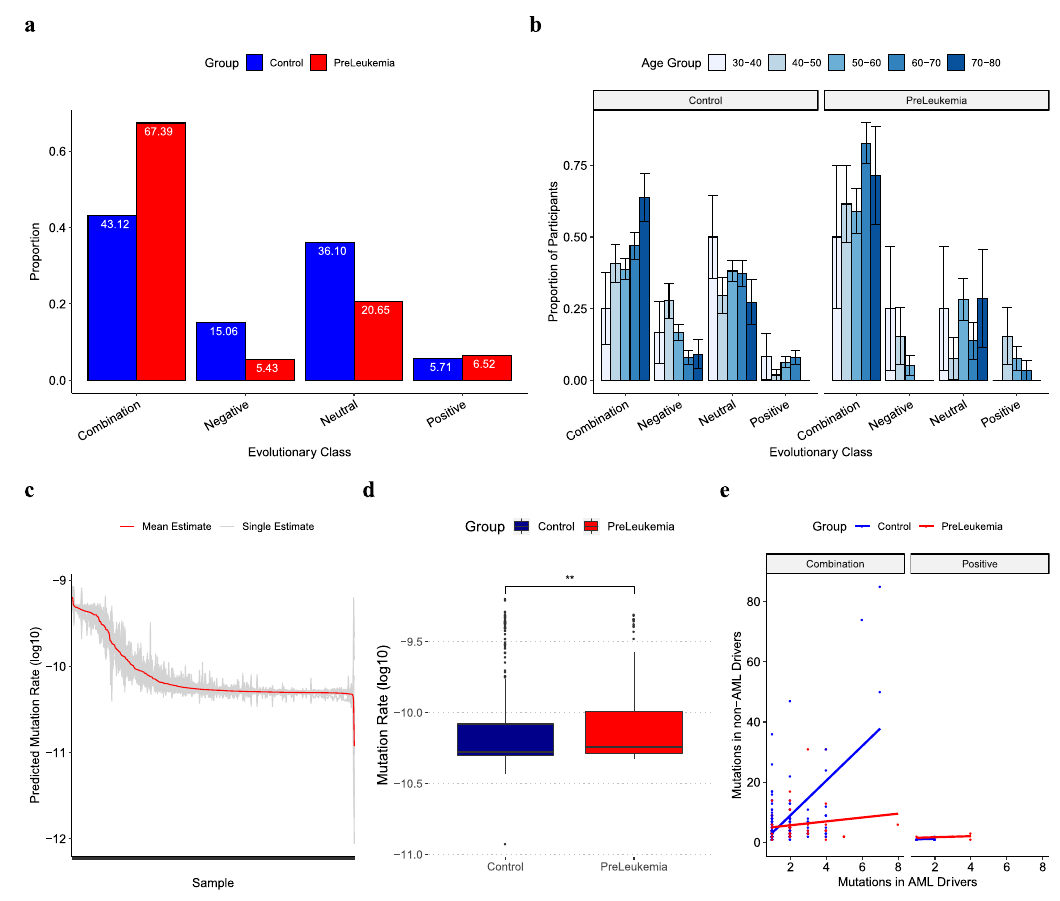
Fig. 2 Hematopoietic evolution is governed by a range of evolutionary dynamics. a Evolutionary classes in preleukemic (red) and healthy (blue) blood populations. The majority of blood populations do not evolve neutrally (72%). Similarly, only 9% of individuals fi t positive models of evolution. Populations do not evolve neutrally in the majority of preleukemic cases (79%) and healthy controls (64%). The majority of preleukemic (62%) and the plurality of healthy (43%) individuals fi t combination (both bene fi cial and damaging mutations arising) classes of evolution. b Age-associations across evolutionary class predictions. Participants were strati fi ed into 10-year age windows. Age intervals range from 30 – 40 (light blue) to 70 – 80 (dark blue). Each bar represents the proportion of individuals within each age bin fi tting each evolutionary class for preleukemic individuals ( n = 92) and healthy controls ( n = 385). Standard errors for each proportion were calculated by p (1 − p )/ n where p is the proportion of individuals fi tting a particular class and n is the total population. We observe signi fi cant differences in the proportion of individuals fi tting combination classes of evolution in the 50 – 60 age range (Pearson ’ s chi-squared test, X 2 = 4.54, p -value = 0.03), the 60 – 70 age range (Pearson ’ s chi-squared test, X 2 = 10.55, p -value = 0.001), and in the neutral class of evolution in the 60 – 70 age range (Pearson ’ s chi-squared test, X 2 = 4.73, p -value = 0.03). c Range of mutation rate estimations across a cohort of participants. We show the estimated mutation rate for each sample from each DNN in our ensemble (gray). The mean estimate from the classi fi er outputs is shown in red and samples are sorted by the mean estimated mutation rate. Mutation rates ( y -axis) are log-transformed and scaled to a population size of 10,000. d Preleukemic blood populations have a higher mutation rate than healthy controls. Each boxplot illustrates the distribution of estimated mutation rates across samples grouped according to outcome status (control ( n = 385): blue, preleukemic ( n = 92) = red), the midline represents the medians, the upper and lower bounds the interquartile ranges, and the whiskers extend to 1.5 times the interquartile range. The level of signi fi cance is indicated as follows: ns: p > 0.0, * p -value < = 0.05, ** p -value < = 0.01, *** p -value < = 0.001, **** p -value < = 0.0001. Preleukemic cases are found to have a modest yet signi fi cantly higher mutation rate than controls (Two-sided Wilcoxon rank-sum test, W = 14336, df = 1, p -value = 0.004). e Relative passenger to driver mutation proportion across evolutionary classes. The number of mutations in known driver genes is plotted against the number of mutations in non-driver genes for each individual blood population with healthy controls shown in blue and preleukemic individuals in red. We used linear regression to compare the relationship between the number of mutations falling into known driver genes versus non-driver genes in cases (red) and controls (blue) fi tting combination and positive evolutionary classes. The 95% con fi dence level interval for predictions from each linear model is indicated in gray. In the combination model, we fi nd a signi fi cant interaction between the number of mutations occurring in non-driver genes compared to driver genes in controls ( β = 5.76) and cases ( β = 0.642); F (1, 224) = 28.5, p - value = 2.23e − 07. However, in the positive class, we did not fi nd a signi fi cant interaction between the number of mutations occurring in non-driver genes compared to a driver in controls ( β = 0.16) and cases ( β = 0.17); F (1,12) = 0.0004, p -value =